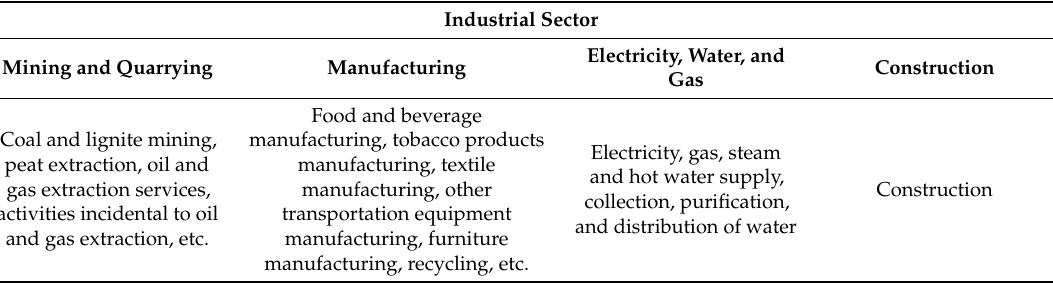
Table 1. Industrial sector and